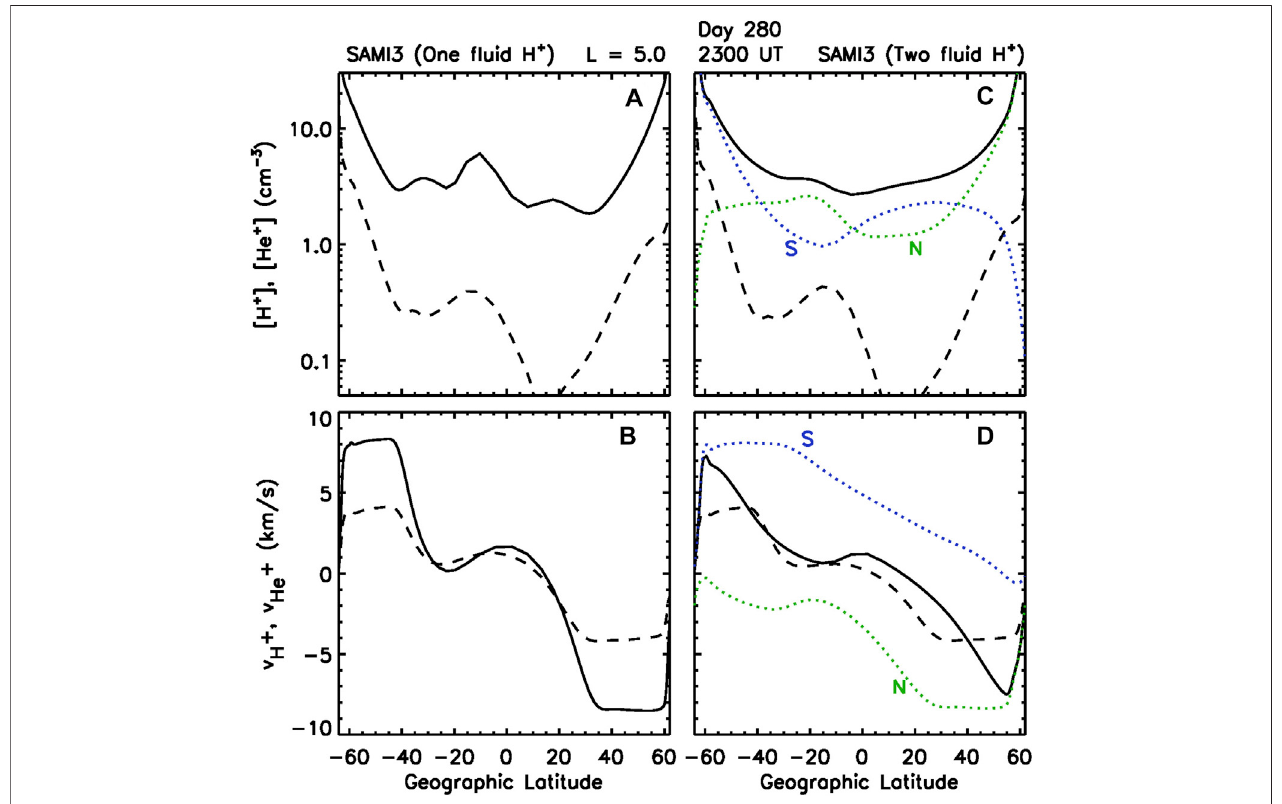
FIGURE3|(A,C) H + (solid)andHe + (dashed)iondensitiesand (B,D) H + (solid)andHe + (dashed)ionvelocitiesplottedversuslatitudealonga fi xed-longitude(0.3 ° ) L (cid:2) 5 fi eld line from (A, B) SAMI3 and (C, D) two-stream SAMI3. The density peak near the equator (-10 ° ) in panel (A) largely disappears in the two-stream SAMI3 simulation (C) . Panels (C, D) also show the separate H + N (H + with its source in the north) and H + S fl uids. We see that H + from the south rushes northward ( v > 0) while H + from the north rushes southward ( v < 0). This is at the same time as panels (b,f) of Panel 2